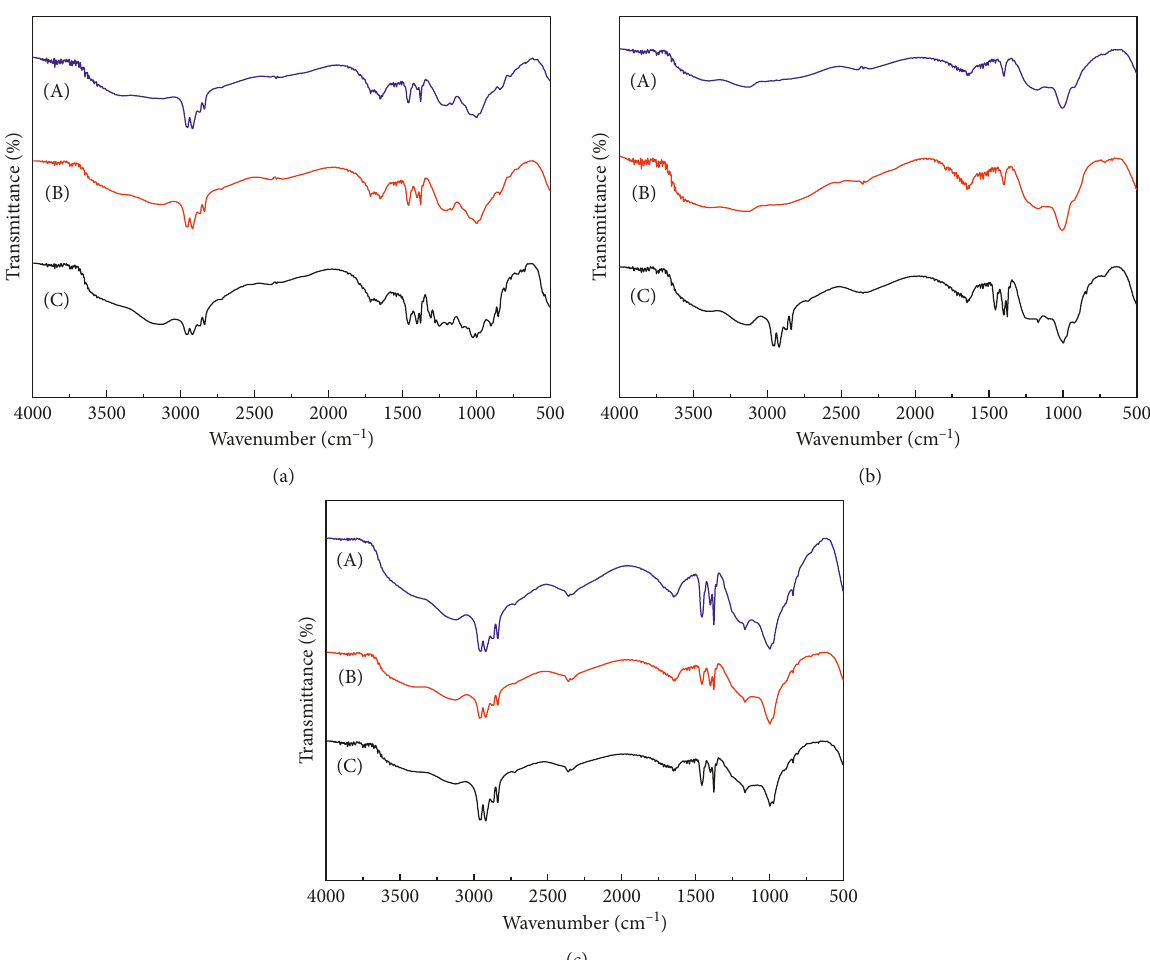
Figure 12: FT-IR spectra of char of IFR-PP (PER) (A), IFR-PP (PEPA) (B), and IFR-PP (PBPP) (C) in (a) 300 ° C, (b) 500 ° C, and (c) after cone calorimeter